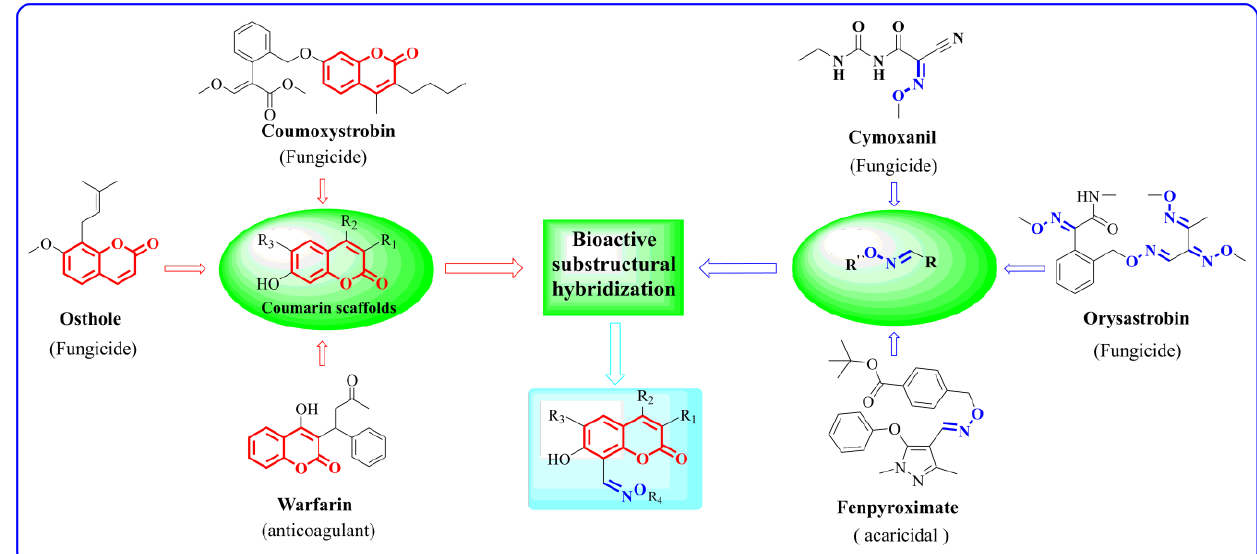
Figure 1. Design strategy of target 7-hydroxycoumarin oxime ether structures.